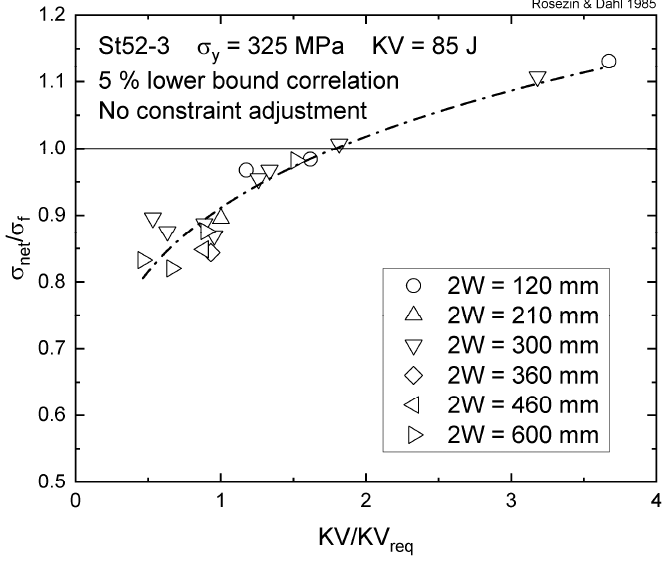
Figure 16. Compilation of proportional net section stress divided by flow stress as a function of ratio between the Charpy-V impact energy and estimated required impact energy to obtain the plastic limit load for the second St52-3 steel. Calculation based on conservative correlation, Equation (5), and omitting constraint correction.